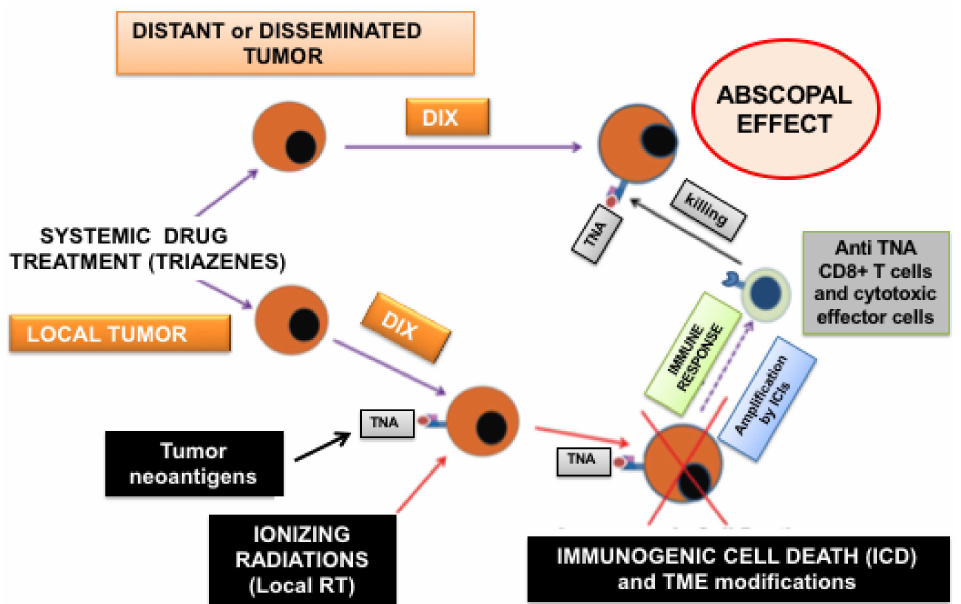
Figure 1. Main players involved in the chemo-radiation-induced and immuno-mediated abscopal effect. Systemic admin- istration of selected drugs (e.g., triazene compounds) in tumor-bearing hosts can result in the induction of novel tumor antigens (tumor neoantigens, TNA, presented by MHC molecules), a phenomenon that has been termed “drug-induced xenogenization” (DIX, [19]). A portion of the malignant cells (e.g., a metastatic lesion in a clinical setting of a local “in situ vaccine” for advanced solid tumors [20]) is exposed to ionizing radiation. RT must be properly delivered to avoid immune suppression and to produce immunogenic cell death (ICD) and tumor microenvironment (TME) modifications that are able to activate systemic cell-mediated immunity. Immunotherapy (IT) including immune checkpoint inhibitors (ICIs) also plays an important role in generating cytotoxic effector cells against non-irradiated distant and/or disseminated xenogenized tumor cells (abscopal